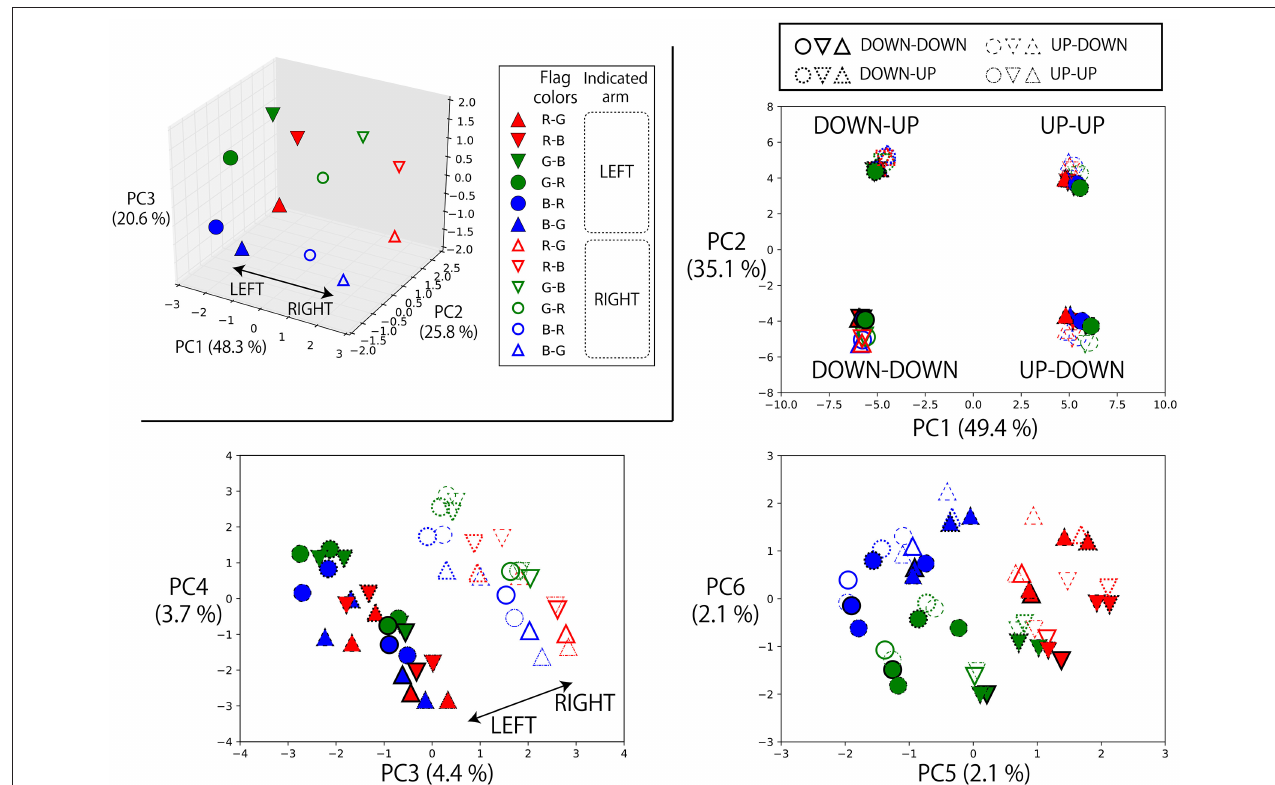
FIGURE 6 | Top left: The states of the memory cells after the instruction “(L-flag color word) up true” or “(R-flag color word) up true” is given to the robot projected onto the space spanned by PC1, 2, and 3. Here, the robot is always waiting in the DOWN-DOWN posture, but the situations are different with respect to the colors of the flags grasped in each hand. For example, the filled blue circle is the activation after receiving “blue up true” in the situation B-R in which a blue flag is in the left hand and a red flag is in the right. In this task, which arm should be moved cannot be determined from the given objective word alone. However, in the PC1 direction, which arm is indicated by the objective word is represented. The RNN learned to integrate the objective word information and the current visual information, and acquired a representation corresponding to the meaningful pair of “left–right”. By using these activations, the robot could choose a correct arm for each trial. Others: We also plotted the internal states after giving these instructions to the robot that is waiting in the other postures, together with the internal states on the DOWN-DOWN condition. We projected them onto the PC1–2, PC3–4, and PC5–6 space. Note that we carried out PCA again by using the internal states on all of these conditions. Plot colors and shapes are as in the top left panel except that the frame lines differ according to the robot current posture. In this case, the current posture information is strongly reflected to the internal states, thus it is encoded in the PC1–2 plane. But the representation corresponding to “left” and “right” is still able to be seen easily in the PC3–4 plane. The visual information was encoded in the PC5–6 space although the hexagon shape was a little